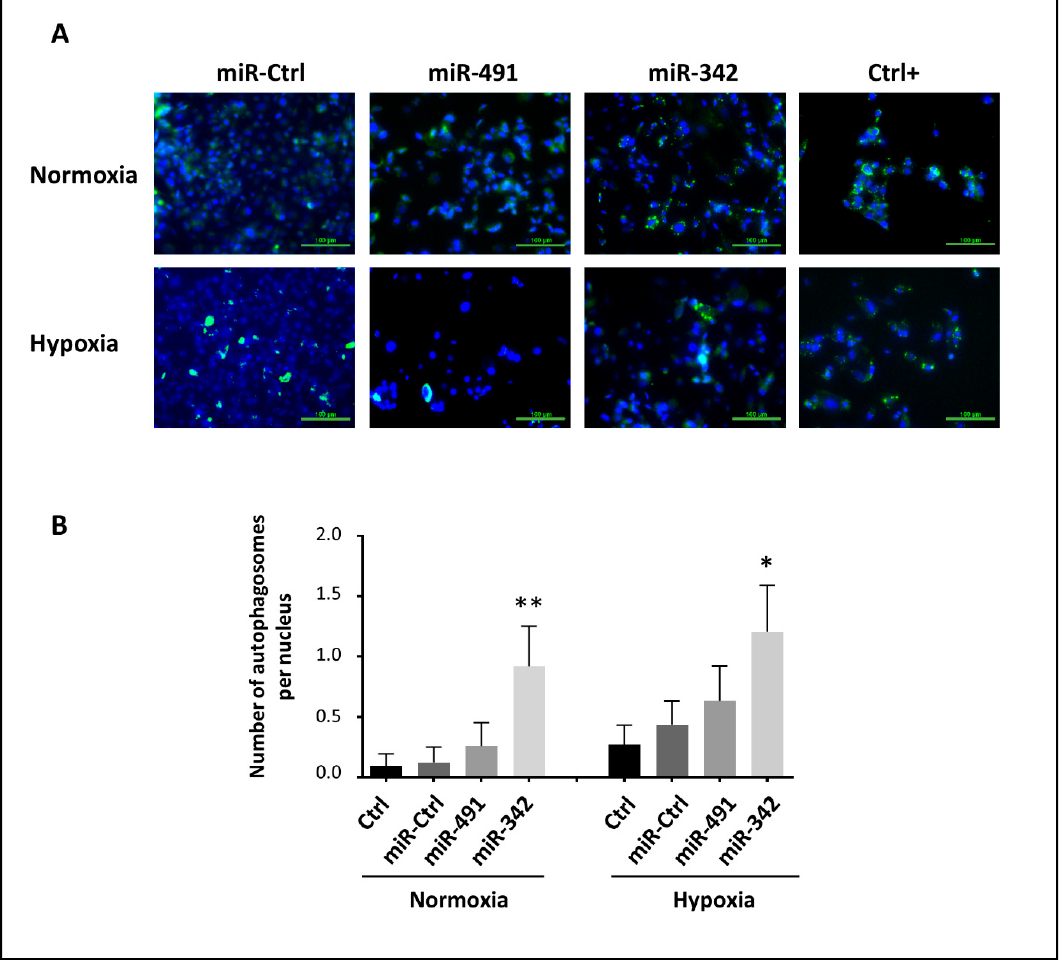
Figure 7. Effects of miR-491-5p and miR-342-5p on the autophagic activity of SW1353 cells. SW1353 cells were cultured and transfected as described in Figure 5, with an additional positive control (5% FCS in PBS for the last 24 h). Analyses were carried out 72 h post-transfection. The autophagosomes (green) and the nuclei (blue) were labeled as described in the Materials and Methods section. ( A ) The images shown are representative of the experimental results obtained. Scale bar: 100 µm. ( B ) The graph gives the number of autophagosomes normalized to the number of nuclei (mean ± SD of three independent experiments). The significance of the results between miR-Ctrl and miRNA-treated cells was assessed using one-way ANOVA (*: p < 0.05, **: p < 0.01).